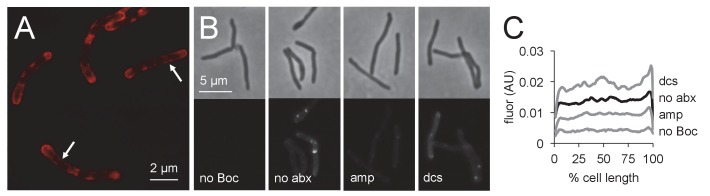
Penicillin-binding proteins are present along mycobacterial cell periphery.(A) M. smegmatis merodiploid expressing PonA1-mRFP imaged by structured illumination microscopy. Arrows highlight sidewall signal. (B) Bocillin labeling of live M. smegmatis pre-treated or not with ampicillin or d-cycloserine. No Boc, autofluorescence; no abx, no antibiotic. (C) Quantitation of cellular fluorescence for B. 60 < n < 180. Signal was normalized by cell length and brighter poles oriented to the right-hand side of the graph. AU, arbitrary units.10.7554/eLife.37243.025Figure 5—figure supplement 3—source data 1.Structured illumination microscopy images of PonA1-mRFP and conventional fluorescence microscopy images of M. smegmatis labeled with Bocillin-Fl.